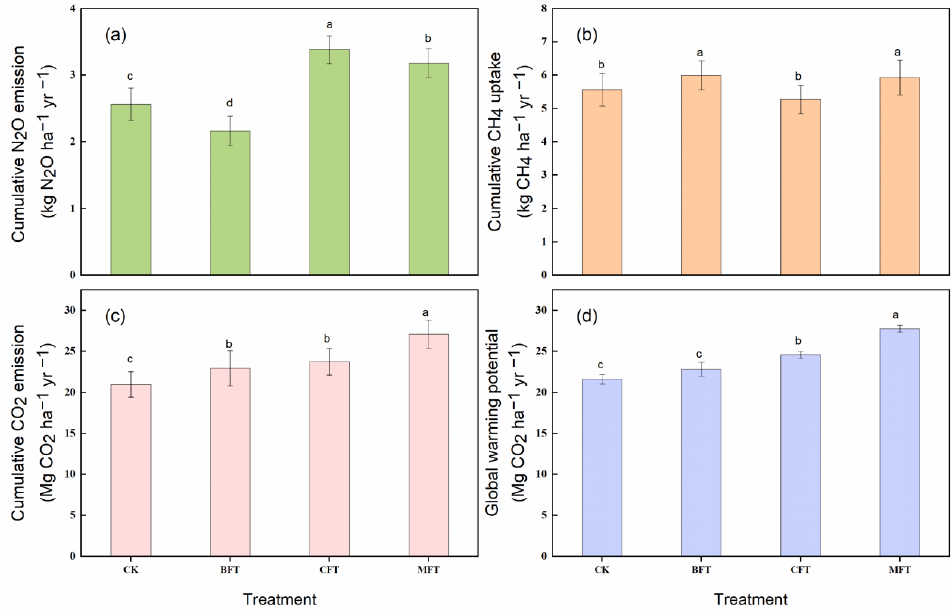
Figure 4. Effects of various fertilization treatments on annual cumulative soil: ( a ) N 2 O emission, ( b ) CH 4 uptake, ( c ) CO 2 emission, and ( d ) global warming potential in the Pleioblastus amarus plantation. The standard deviation is indicated by vertical bars. The letters above the bars denote significance in CK, CFT, CFT, and MFT)